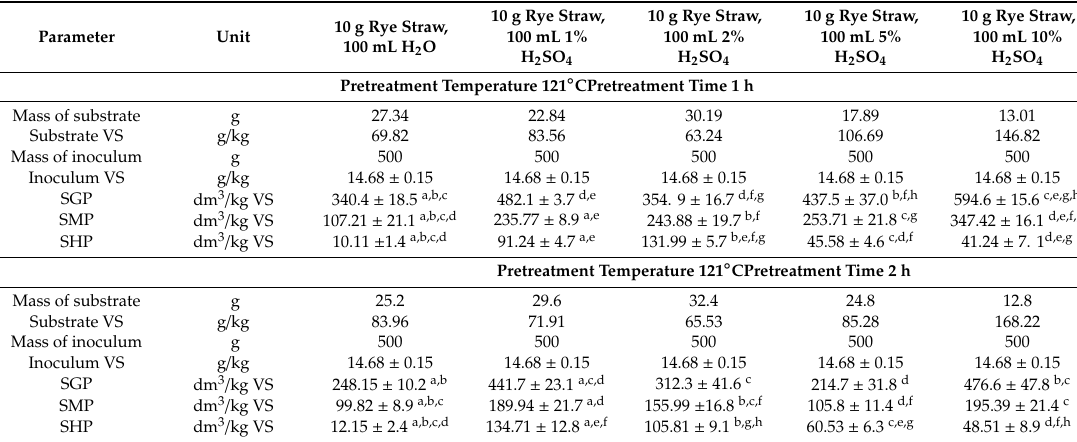
Table 2. Results and parameters estimated from batch digestion